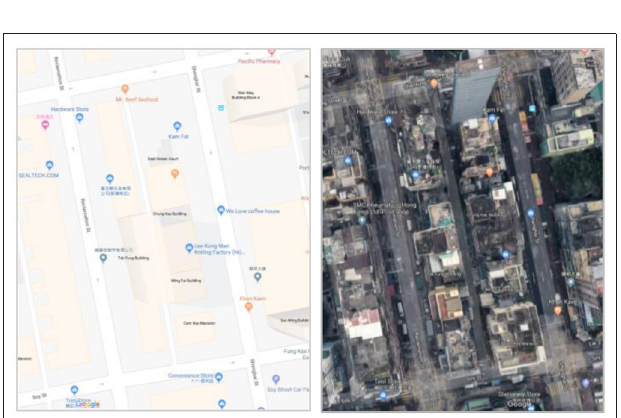
FIGURE 3 | An urban alley site between the Reclamation Street and the Shanghai Street in Hong Kong. Source: Google Map.